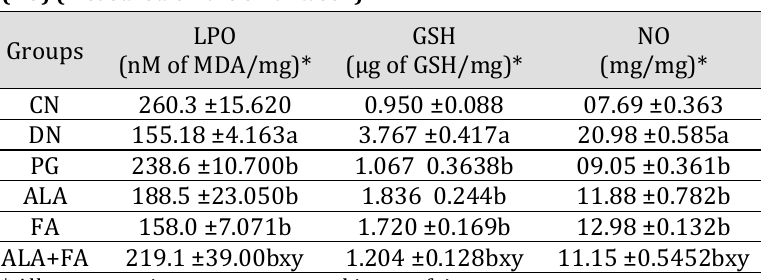
Table 2. Effect of ALA, FA, and their combination on the level of Lipid peroxidation (LPO), Reduced glutathione (GSH), and Nitric oxide level (NO) (measured on the sixth week).